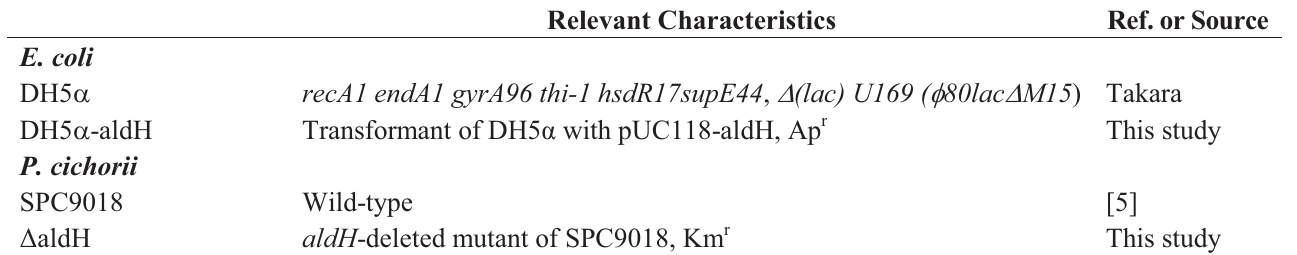
Table S3. Strains and plasmids used in this